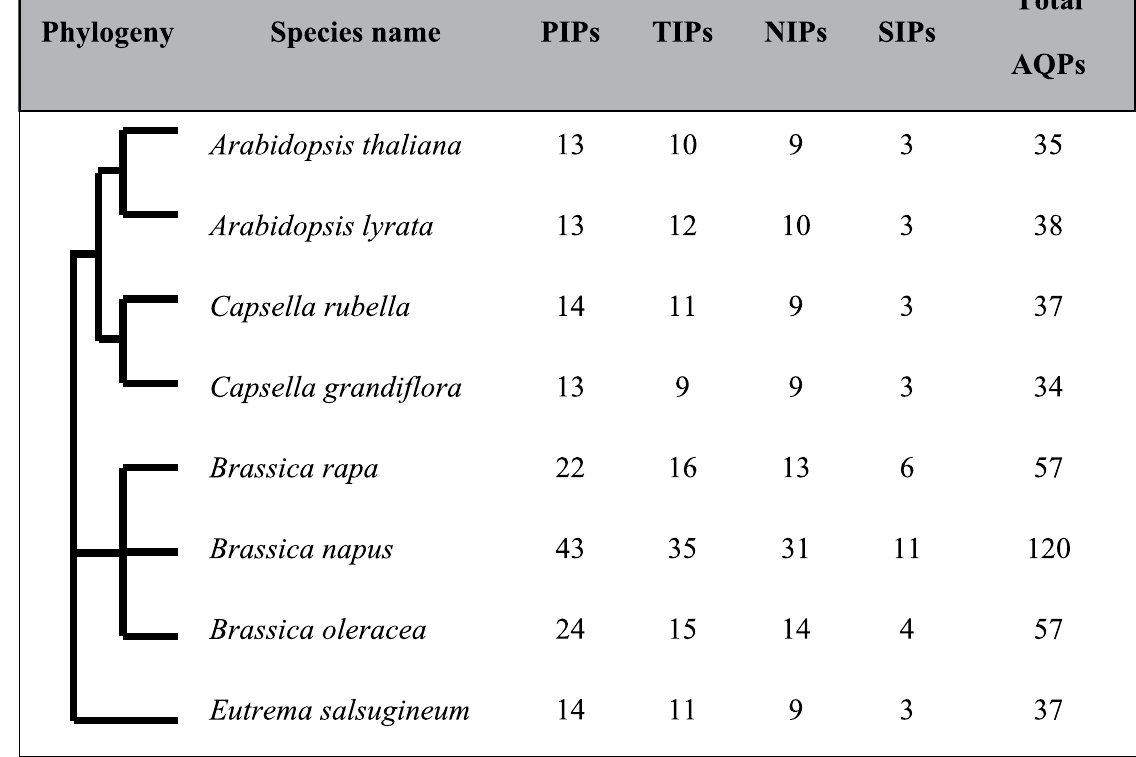
Table 1 . Genome-wide distribution of aquaporins in Brassicaceae species. PIP, Plasma membrane intrinsic protein; TIP, Tonoplast intrinsic protein; NIP, Noduline-26 like intrinsic protein; SIP, Small intrinsic protein; AQP, Aquaporin. Phylogeny of the species was constructed using Phylogenetic tree generator (http://phylot.